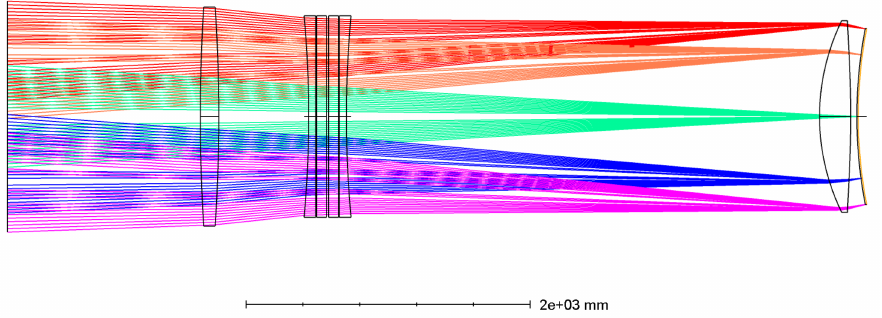
Figure 3. Baseline “GMT Correcting-ADC” (C-ADC) corrector design, incorporating an Amici prism (R-ADC), as given in Figures 6–10 of Ref. [13]. The first element (far left) and last element (far right) are of fused silica. Element 1 is over 1.5 m diameter The Amici prism elements use optical glasses (see Table 6-3 and associated discussion on page 6–13 of Ref. [13]). In this paper “optical glasses” refers to glasses other than pure fused silica. Fused silica is of course a potential crown element for the Amici prisms but the performance in that case is not as good as can be achieved with other crowns.